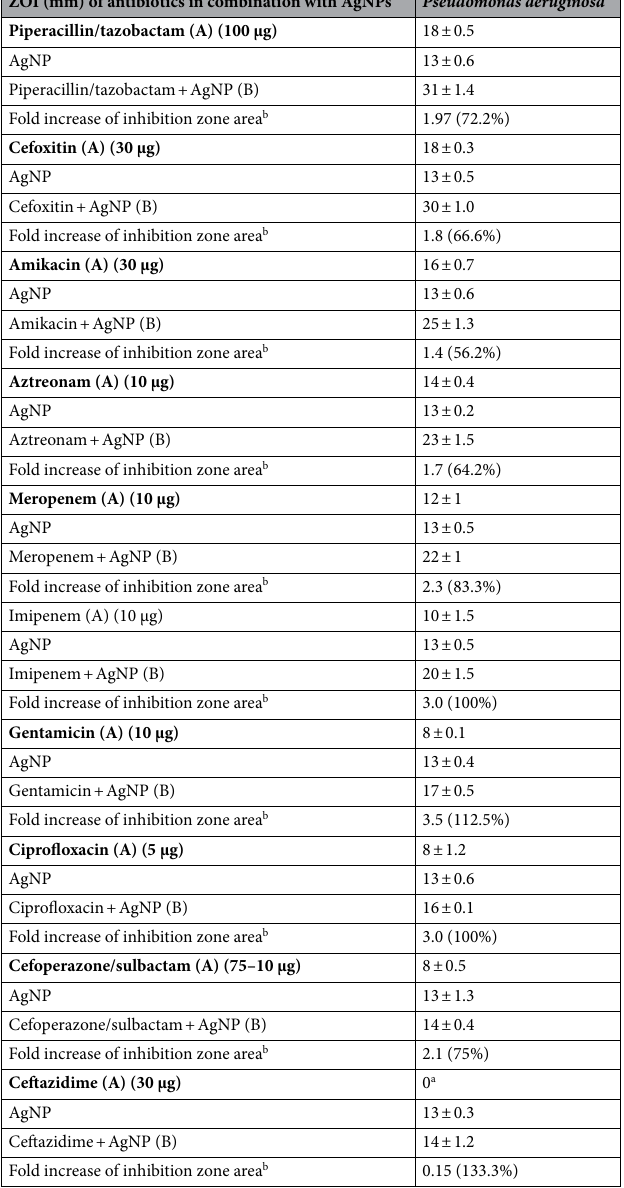
Table 6. Single and combined efficacy of AgNPs and antibiotics against MDR Pseudomonas aeruginosa. Rank order is indicated by Alphabets. Vertically, the ranking is linked to combinations of antibiotics against bacterial isolates; horizontally, the ranking is of bacterial isolates with respect to sensitivity to antibiotic amalgamation (P, 0.05). a Disc diameter (6 mm) was employed for calculation of fold increase in absence of bacterial growth inhibition zone 34 . b Fold increase of inhibition zone area = (B 2 − A 2 )/A 2 As % synergism = ( B − A )/ A × 100 . AgNP silver